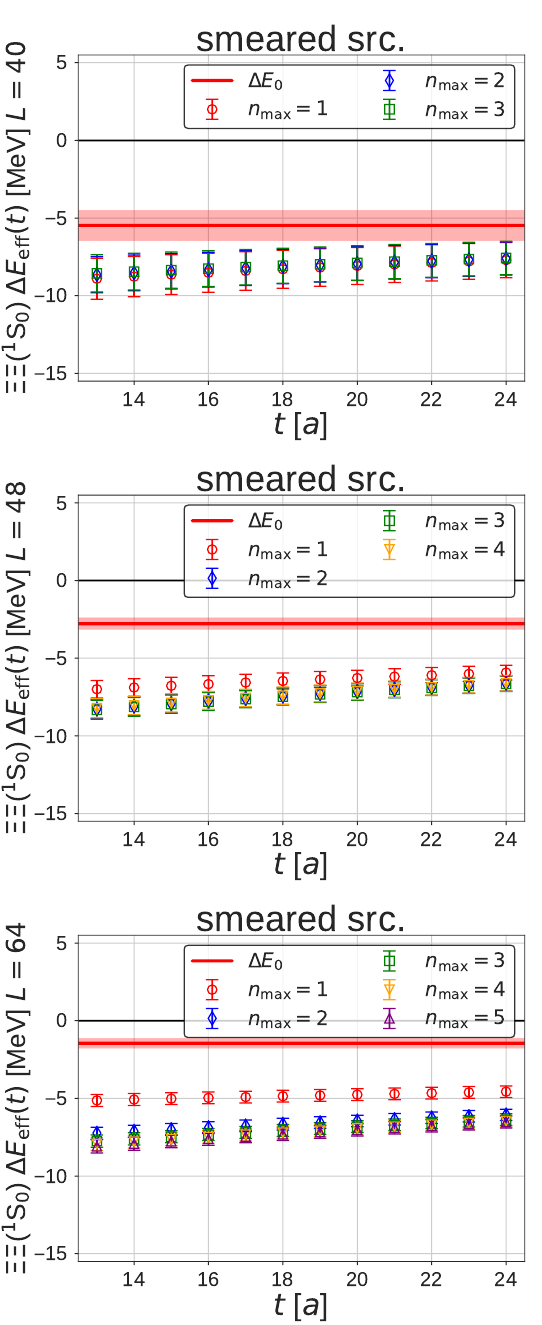
Figure 16 . The mode number ( n max ) dependence of the reconstructed e(cid:11)ective energy shift (cid:1) E e(cid:11) ( t; t 0 = 13 a ) for the smeared source at L = 40 (top), 48 (middle) and 64 (bottom).